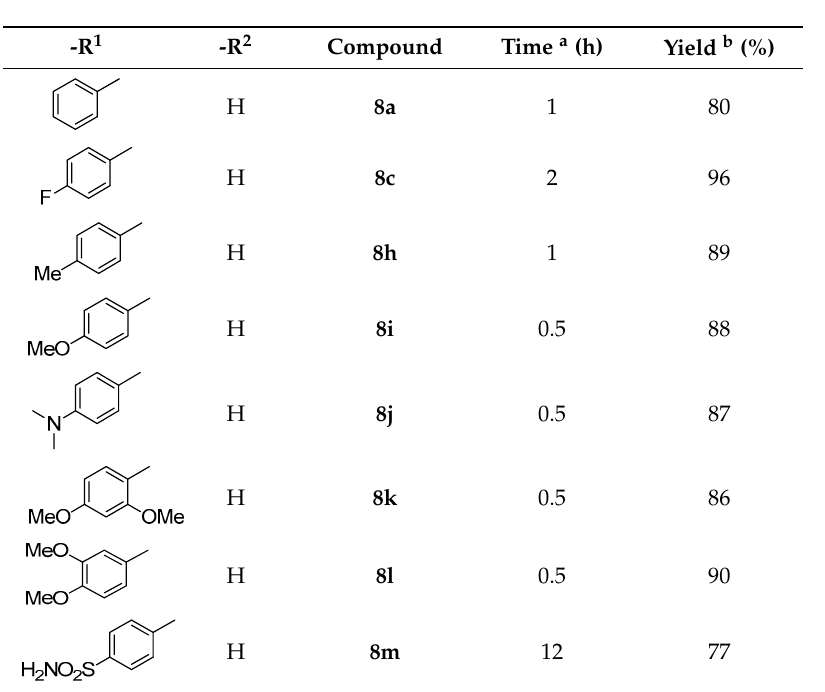
Table 3. Experimental condition optimization for the intramolecular metal-catalyzed cyclization of 12 . Entry CuI (mol %) Ligand a Cs 2 CO 3 ( Equiv)